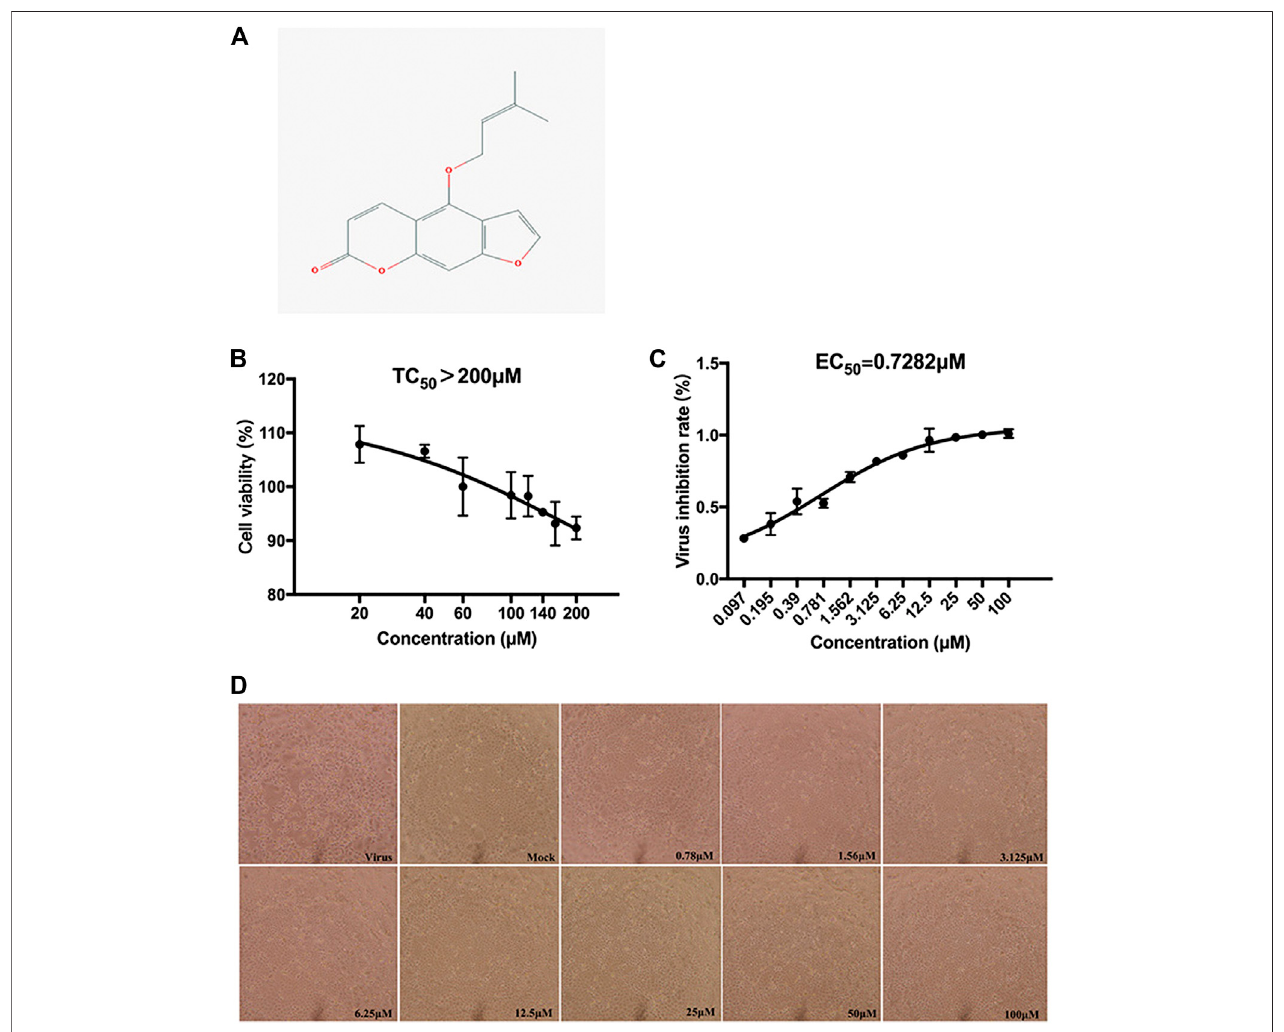
FIGURE 2| Chemical structure and the inhibition of CPE of isoimperatorin. (A) Chemical structure ofisoimperatorin. (B) Cytotoxicity of isoimperatorin. MDCK cells weretreatedwithaseriesdilutionofisoimperatorinfor48 hand detected byCCK-8 assay. (C) MDCK cellswereinfected withH1N1 A/PR/8/34 in fl uenzavirus,andthen the antiviral effects of isoimperatorin were detected by CCK-8 assay. (D) Virus-induced CPE in different treatments was observed under a microscope. Data are representative of three independent experiments (mean ± SEM). Statistical signi fi cance was analysed by one-way ANOVA. # p < 0.05, ## p < 0.01, relative to the mock control group. *p < 0.05, ** p < 0.01, relative to the virus